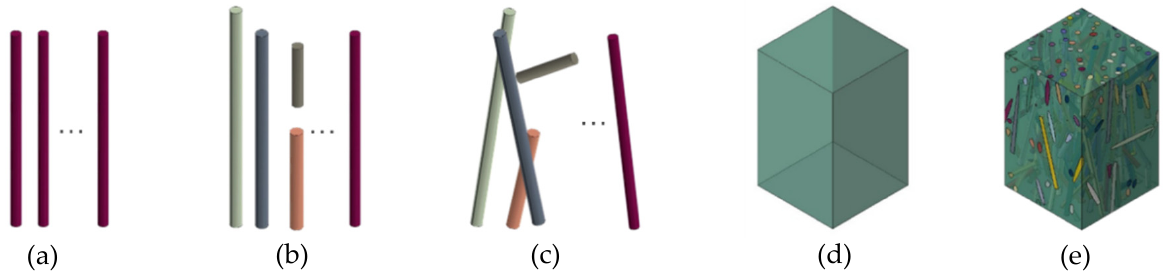
Figure 1. Procedure of the creation of a model with a unique fiber ensemble. ( a ): Considering the number of fibers. ( b ): Fiber length according to LDF. ( c ): Spatial orientation of fibers according to ODF. ( d ): Determining volume. ( e ): Placing fibers to achieve periodic microstructure.